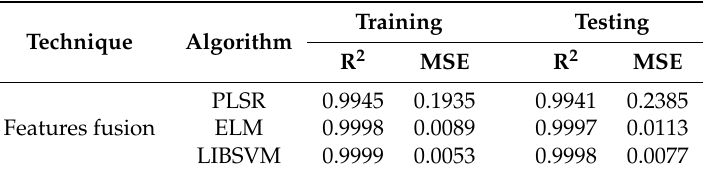
Table 3. Comparison of Partial Least Squares Regression (PLSR), Extreme Learning Machine (ELM), and Support Vector Machines (LIBSVM) Models Based on the Weighted-Fusion